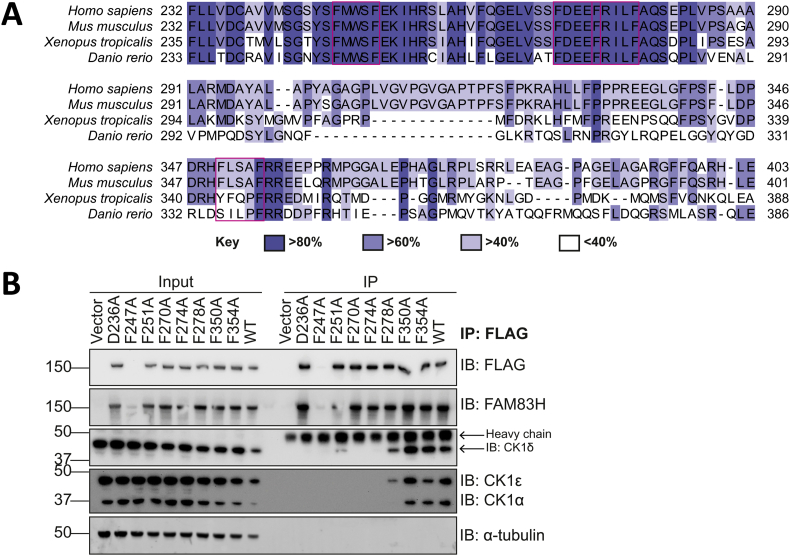
The interaction between FAM83H and CK1 is not mediated by the canonical F-x-x-x-F motif.A Sequence alignment of Homo sapiens (human), Mus musculus (mouse), Xenopus tropicalis and Danio rerio FAM83H proteins. Shading indicates percentage sequence identity as shown in key. F-x-x-x-F motifs are highlighted by a magenta box. Generated using ClustalO [58] in Jalview [59].B U2OS FAM83H-/- cells transiently expressing FLAG empty (vector), FLAG-FAM83HD236A, FLAG-FAM83HF247A, FLAG-FAM83HF251A, FLAG-FAM83HF270A, FLAG-FAM83HF274A, FLAG-FAM83HF278A, FLAG-FAM83HF350A, FLAG-FAM83HF354A and FLAG-FAM83HWT were lysed and FLAG was immunoprecipitated from cell lysates using anti-FLAG antibodies conjugated to agarose gel. Input and IP samples were resolved by SDS-PAGE and immunoblotted (IB) with the antibodies shown. n = 2.